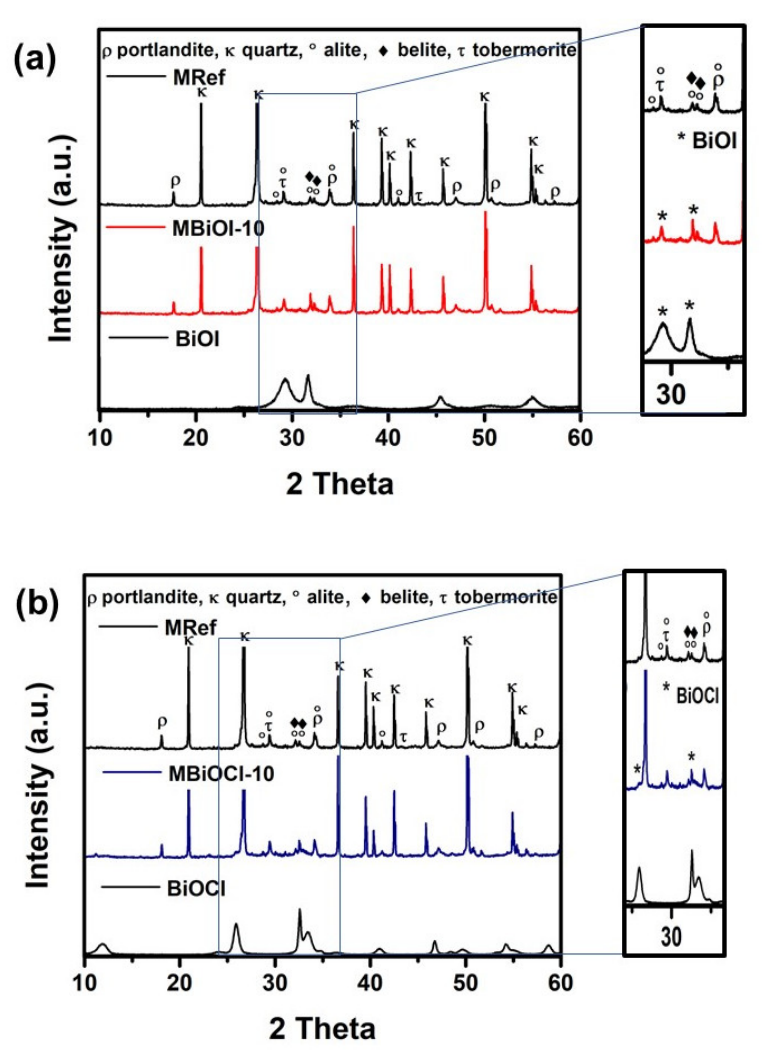
Figure 6. Comparative of XRD patterns of reference (MRef) and photocatalytic mortars: ( a ) MBiOI-10 and ( b ) MBiOCl-10. BiOCl and BiOI are XRD patterns of photocatalysts alone.